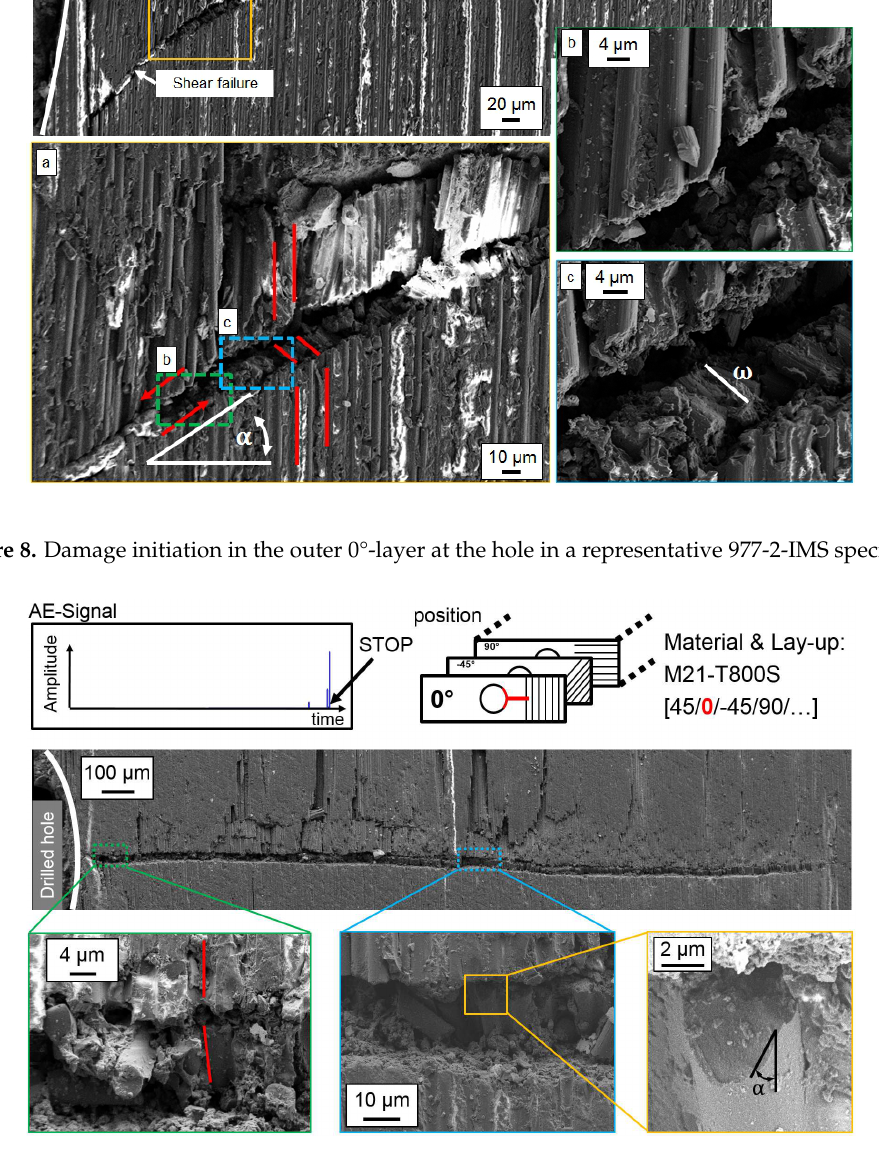
Figure 9. Damage initiation in the outer 0°-layer at the hole in a representative M21-T800S